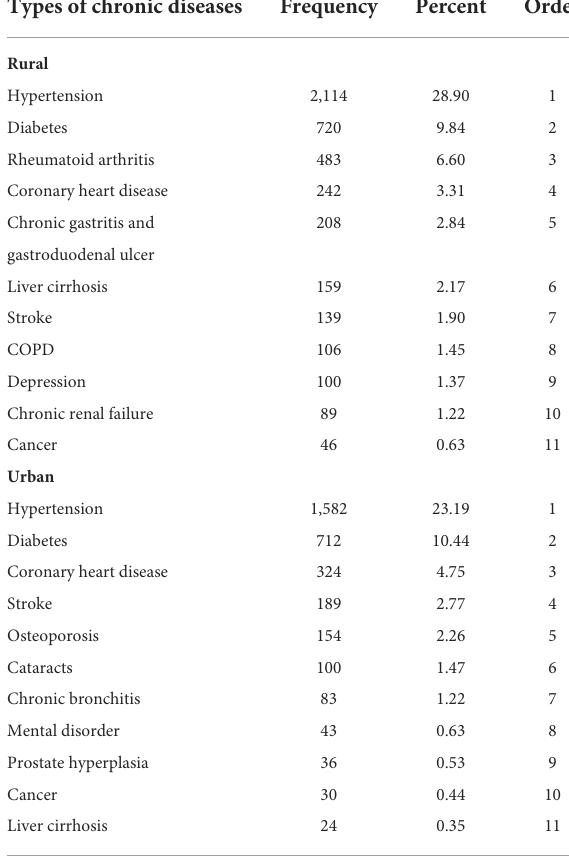
TABLE 1 Prevalence of chronic diseases and their